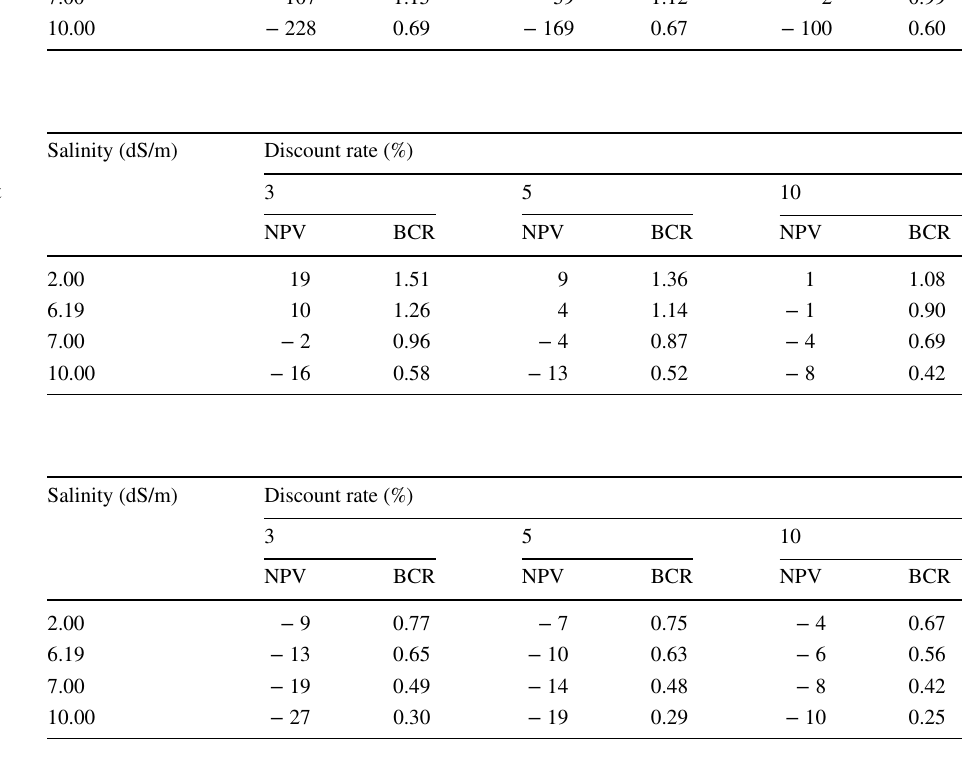
date palm cultivation in million USD for Jericho-Al Ghoor cost–benefit ratio under various discount rates (3, 5, 10%) and salinity levels (2.00, 6.19 (average), 7.00 and 10.00) and accounting for land suitability